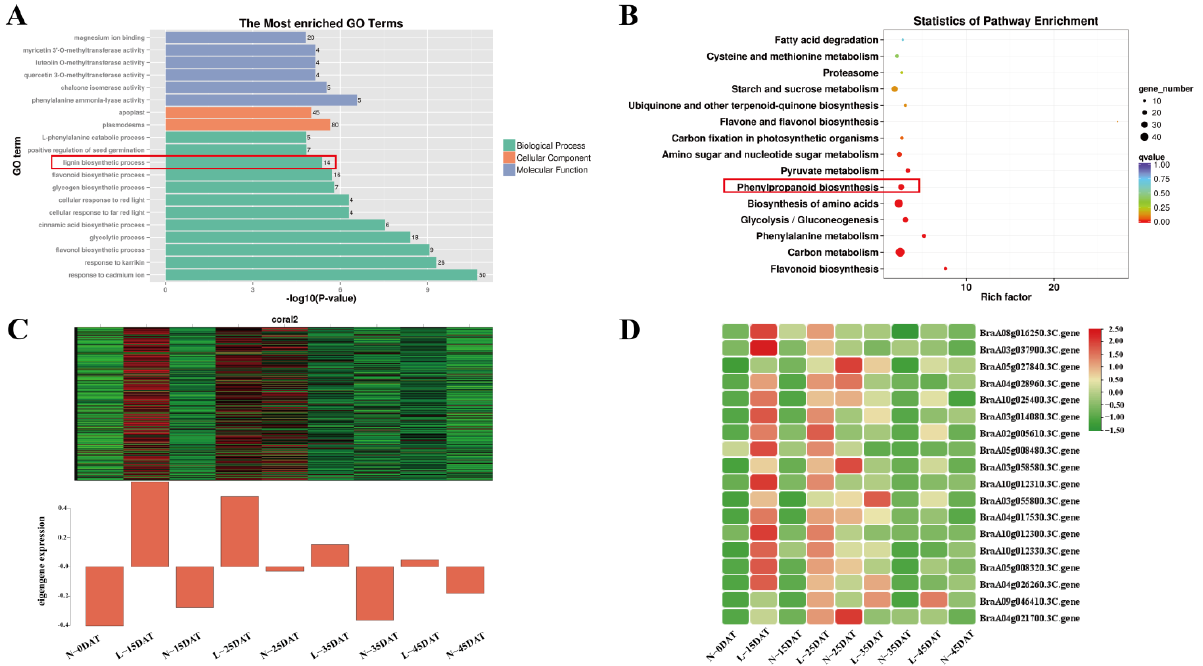
Figure 3. MEcoral2-related genes and their annotations. ( A ) Significant GO terms in MEcoral2. ( B ) Significant KEGG terms in MEcoral2 . ( C ) Eigengene expression during each treatment period in MEcoral2; heatmap from green to red for expression from high to low, respectively. ( D ) Heatmap of lignin-synthesis-related gene expression in MEcoral2. lignin-synthesis-related gene expression in MEcoral2.